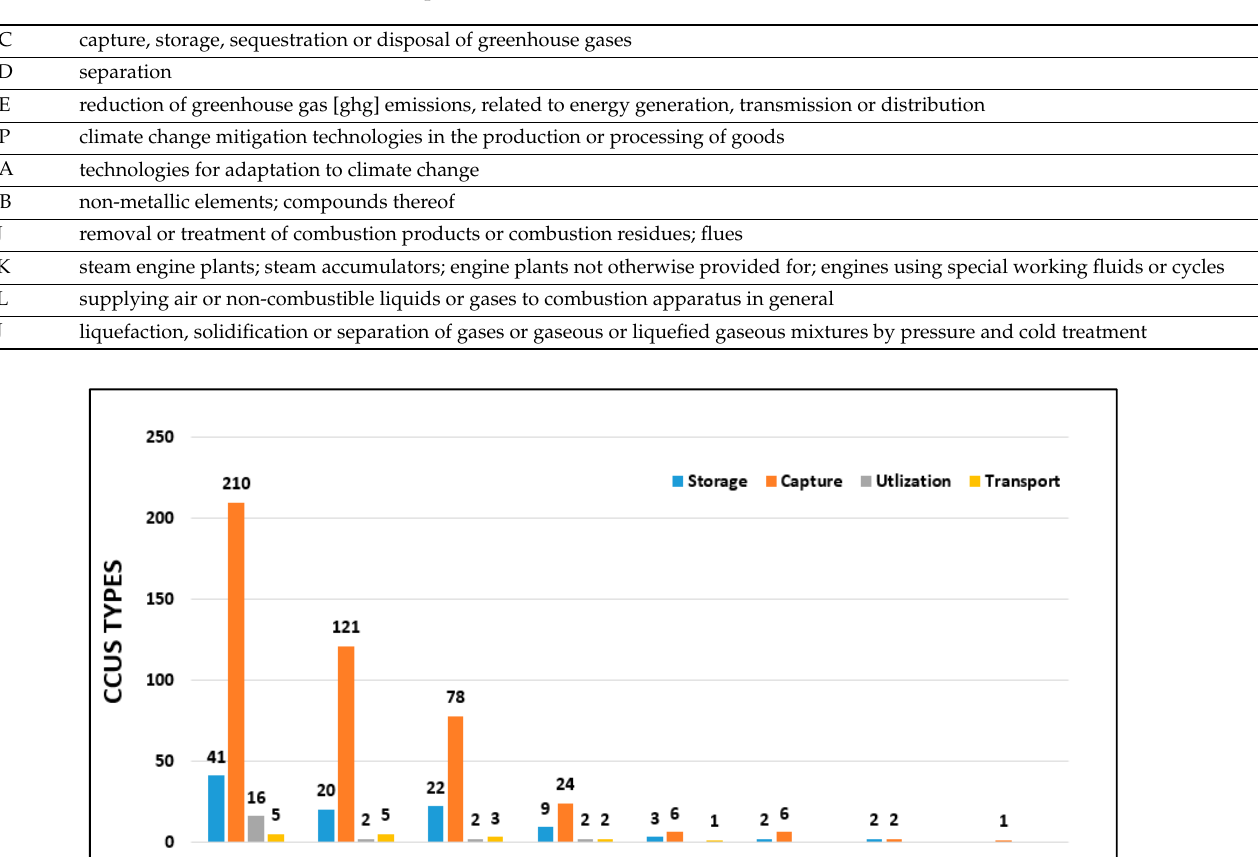
Figure 10. Main classification categories (CPC). Table 3. Description of main CPC.